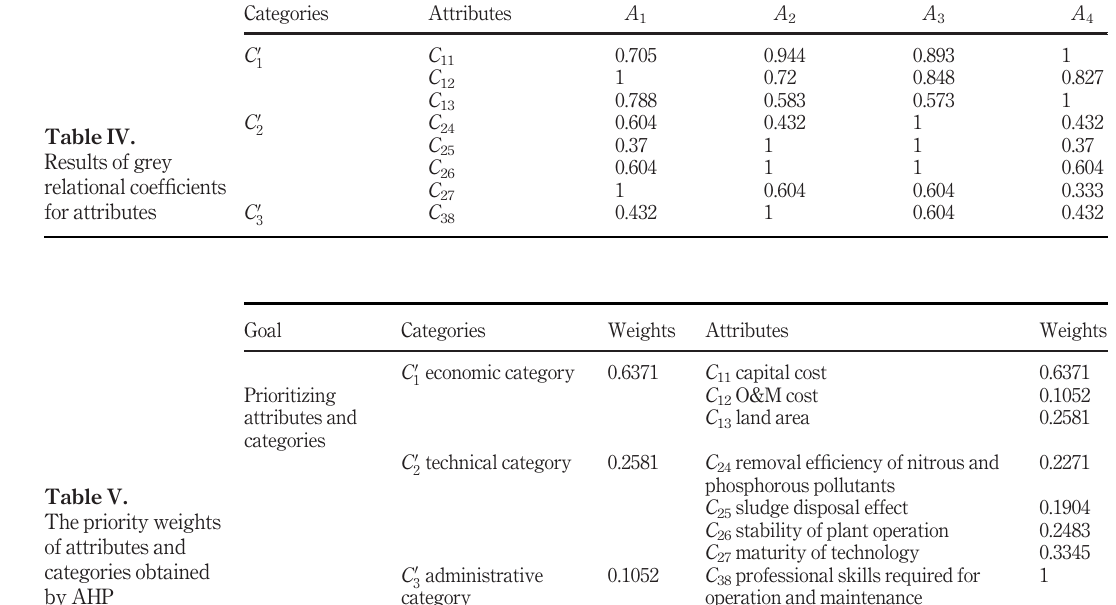
Table V. The priority weights of attributes and categories obtained by